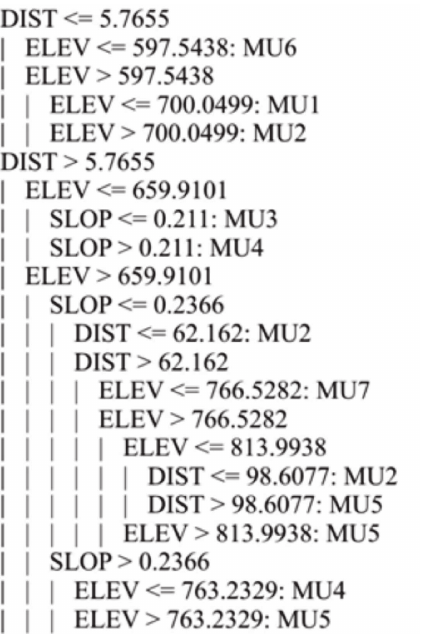
Figure 3. Relationship between the number of leaves in the decision tree and the percentage of misclassified samples. The vertical dashed line indicates the abrupt increase in the number of incorrectly classified instances.